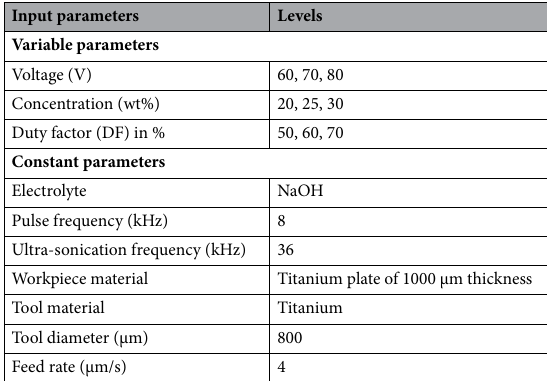
Table 1. Parametric settings for the experiment.